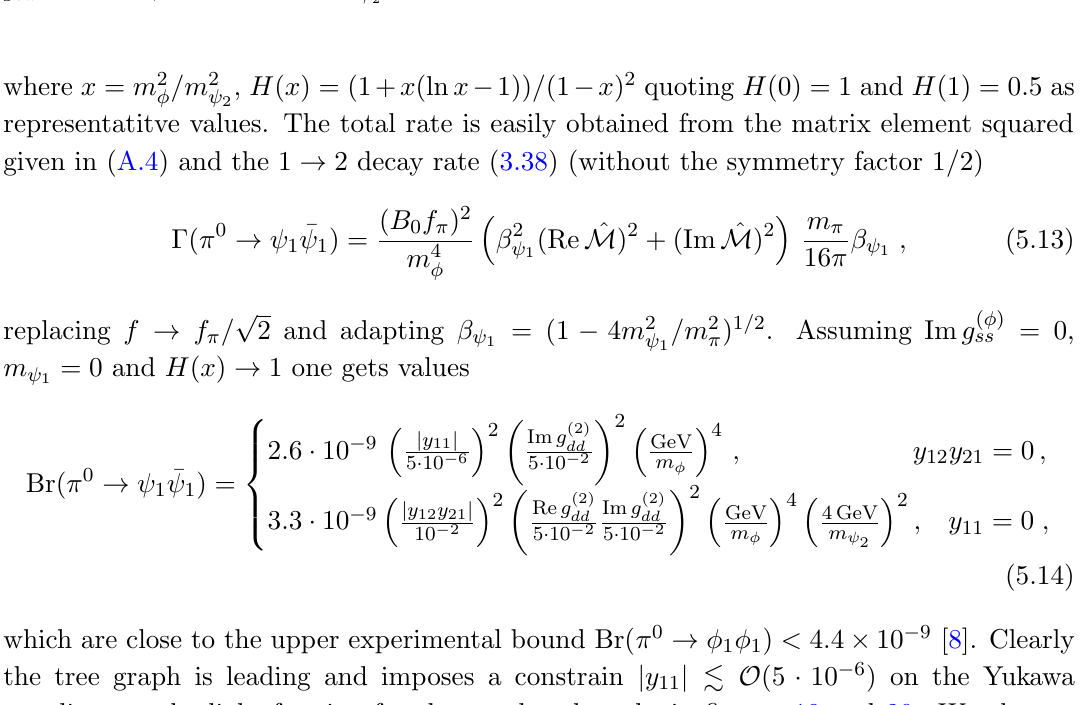
[0 : 55 ; 1 : 2] GeV for two values of 2